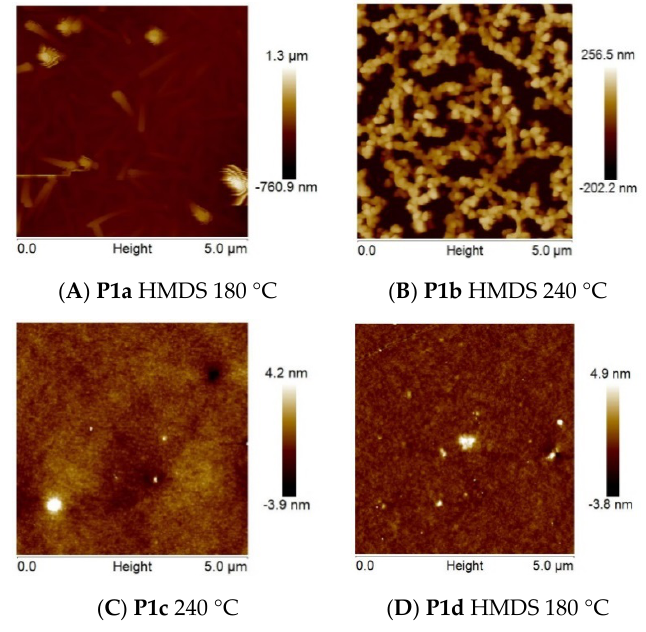
Figure 8. AFM images of P1a , P1b , P1c , and P1d . Image size: 5 × 5 μm.